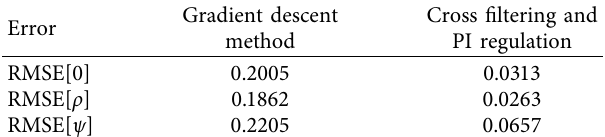
Table 1: Comparison of attitude solution errors based on gradient descent, complementary filtering, and PI adjustment under static state.